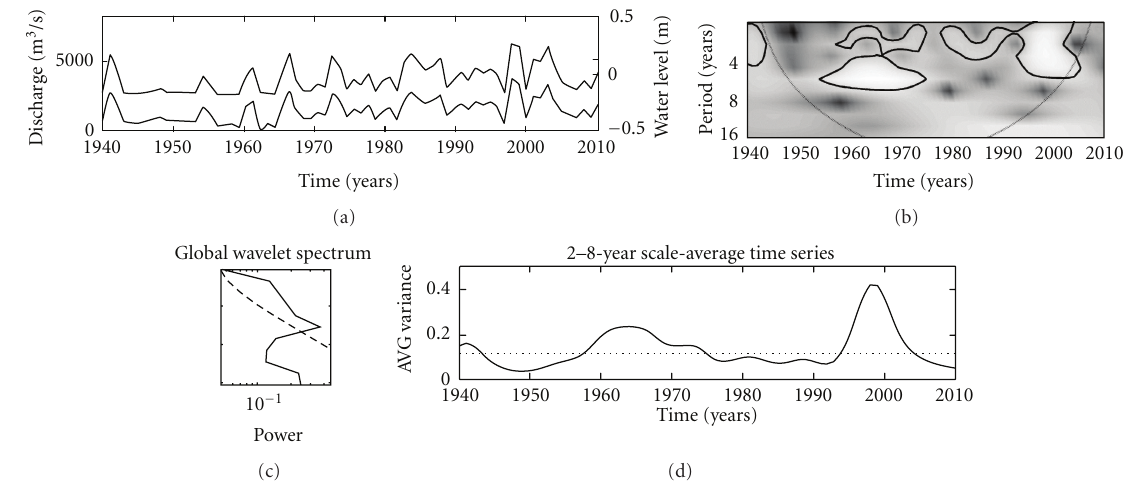
Figure 8: Freshwater discharge and water level in S ˜ ao Lourenc¸o (a), cross-wavelet between freshwater and water level in S ˜ ao Lourenc¸o (b), global wavelet spectrum (c), and average variance between 2 and 8 years (d).